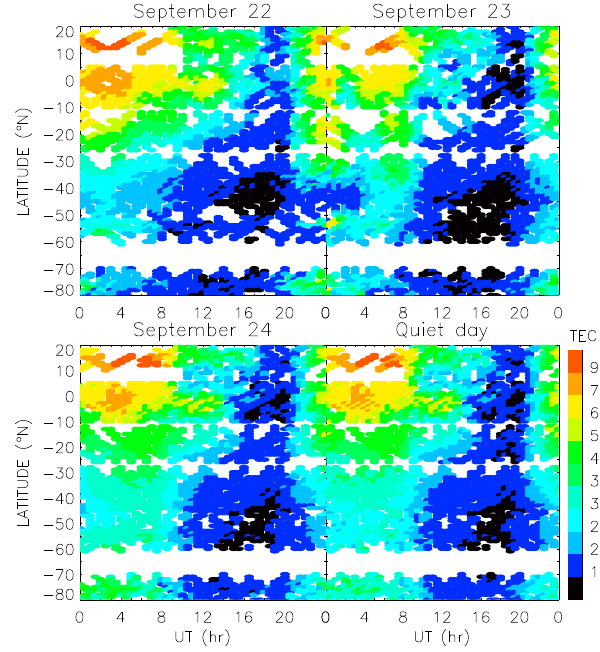
Fig. 6. The latitude-local time (LT=UT+10) contour maps of TEC during quiet days (right bottom), the first day of the storm (left top), the second day of the storm (right top) and the third day of the storm (left